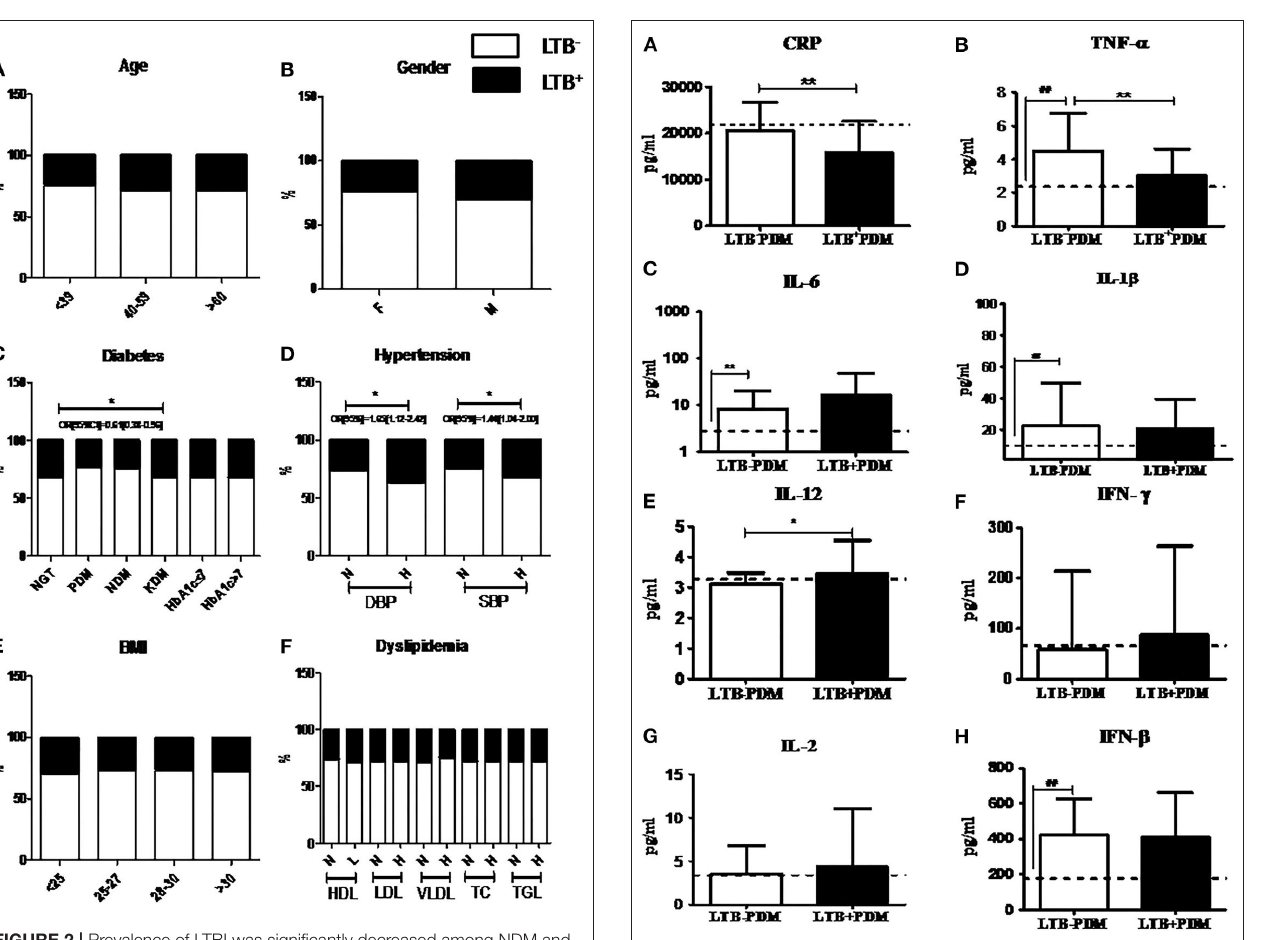
FIGURE 3 | LTBI reduces CRP and TNF- α and increases IL-12 levels in PDM subjects. The circulating levels of pro- inflammatory cytokines, Th1 cytokines and type-1 interferon in PDM subjects were quantified by ELISA. Bar graph showing the circulating levels of CRP (A) , TNF- α (B) , IL-6 (C) , IL-1 β (D) , IL-12 (E) , IFN- γ (F) , IL-2 (G) , and IFN- β (H) in the serum of LTB + PDM ( n = 47) and LTB-PDM ( n = 47) subjects. The basal level, as was seen in LTB-NGT, is shown as dashed line (—-), as reference. Statistical significance was determined by a non-parametric Mann–Whitney U -test and p < 0.05 was considered significant. * p < 0.05; ** p < 0.01 for LTB-PDM vs. LTB + PDM; ## p < 0.01 for LTG-NGT vs.